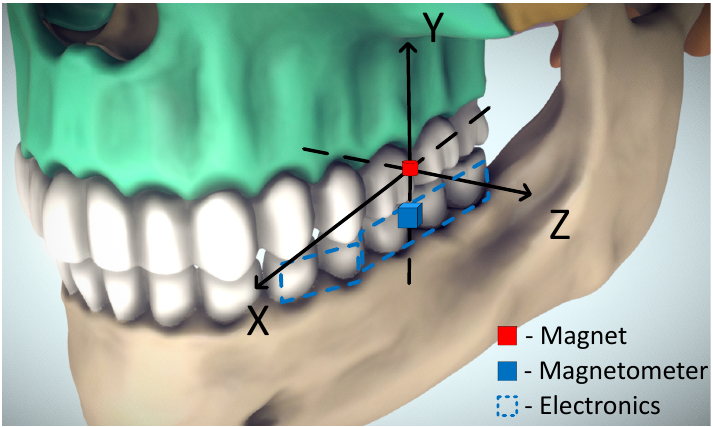
Figure 1. A possible setup for magnetic jaw tracking. Adapted from [9]. For this research, magnet of cylindrical shape was chosen, to have radially symmetric field around one axis of rotation. The strongest and smallest available (in retail) magnet was used. It was a NdFeB magnet with a residual magnetism of 1.4 T, resulting in a uniform magnetization magnitude of M 0 = 1,114,084 A/m directed along rotational axis, length of 2 mm and radius 1